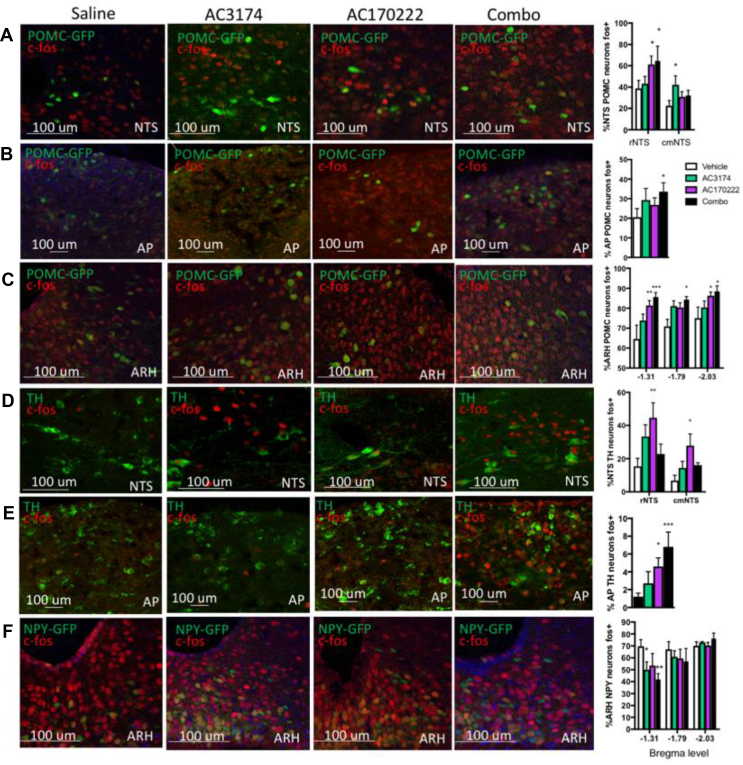
Neurochemical characterisation of the neuronal subpopulations activated by the combination of GLP-1R and CCK1R agonists. Representative images and quantification of neuronal activation in NTS POMC (A), AP POMC (B), ARH POMC (C), NTS TH (D), AP TH (E), and ARH NPY (F) neurons in response to an i.p. administration of saline, GLP-1R agonist AC3174 (1 μg/kg), CCK1R agonist AC170222 (2.5 μg/kg), or AC3174 + AC170222 (1 μg/kg + 2.5 μg/kg). Data are means ± sem. ∗p < 0.05, ∗∗p < 0.01, and ∗∗∗p < 0.001 vs saline. rNTS: rostral NTS; cmNTS: caudomedial NTS.